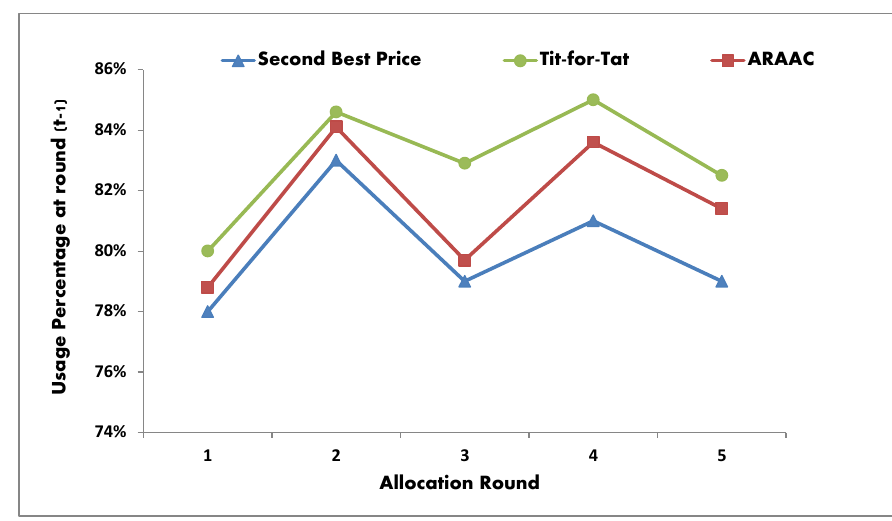
Figure 1. Bandwidth utilization rates of the simulated allocation mechanisms.